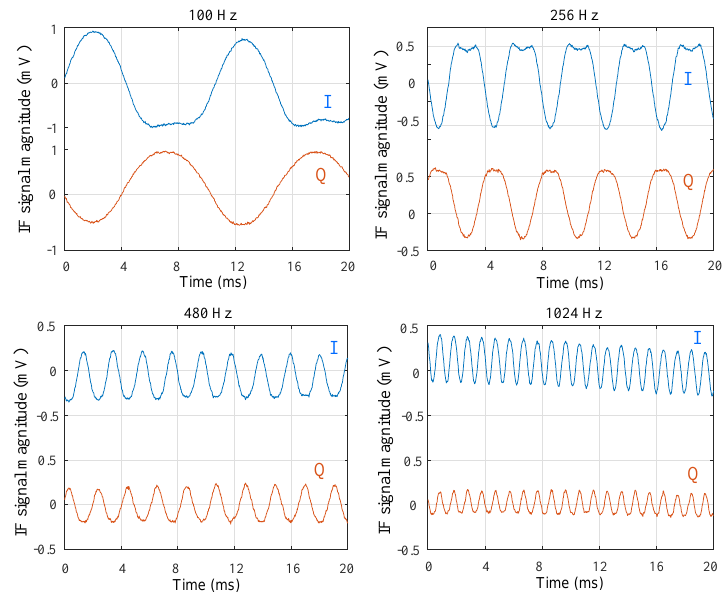
Figure 21. Measurement results for the four tuning forks at various frequencies (I in blue and quadrature (Q) in